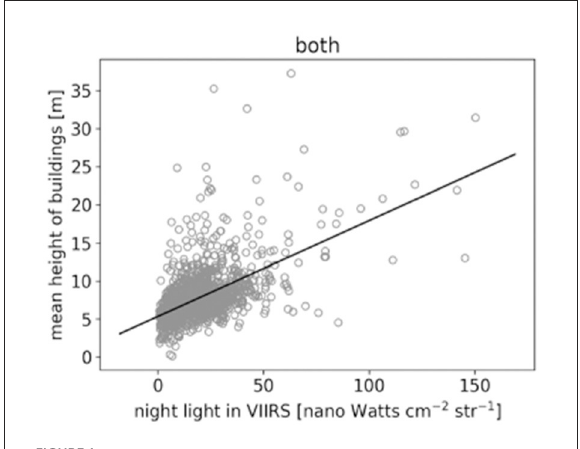
FIGURE1 Scatter plot of the night light and building height for land use ratio of more than 50%.